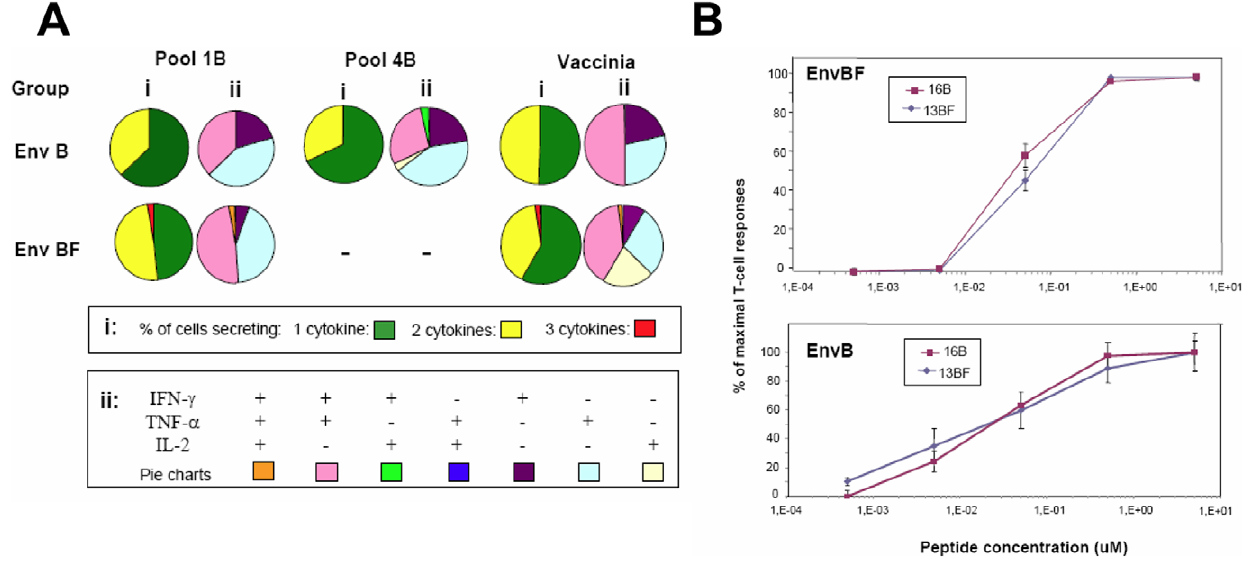
Figure 6. Functional and avidity characteristics of T-cell responses with cross-clade recognition. A ) Quality characterization of T cell responses against Pool 1 and Pool 4 consensus EnvB peptides and against VV antigens, in EnvB and EnvBF immunized mice. Ten days post boost immunization splenocytes were harvested and the percentage of antigen specific CD3 + CD4 + T cells producing IFN- c , TNF- a , or IL-2 was quantified by flow cytometry. i) Data shows the percentage of CD3 + CD4 + T cells secreting one, two or the three cytokines ii) Distribution of the cytokine response comprising the different cell populations producing IFN- c , TNF- a , and IL-2 individually or in combination within CD3 + CD4 + T cells. B ) T cell functional avidity is defined as the concentration required to achieve half-maximal recognition of the wild-type peptide (EC 50 ). Ten days after the boost immunization splenocytes from immunized mice were assayed by Elispot against serial dilutions of 13BF and 16B peptides. Data represents the percentage of the maximal response (net number of SFU/million of cells stimulated with a peptide concentration of 5 m M). Results shown are representative of two independent experiments.